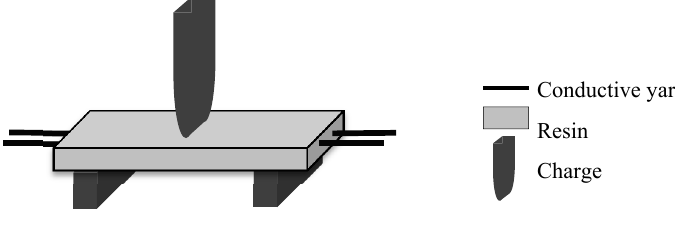
Figure 3. Three-point bending test scheme.